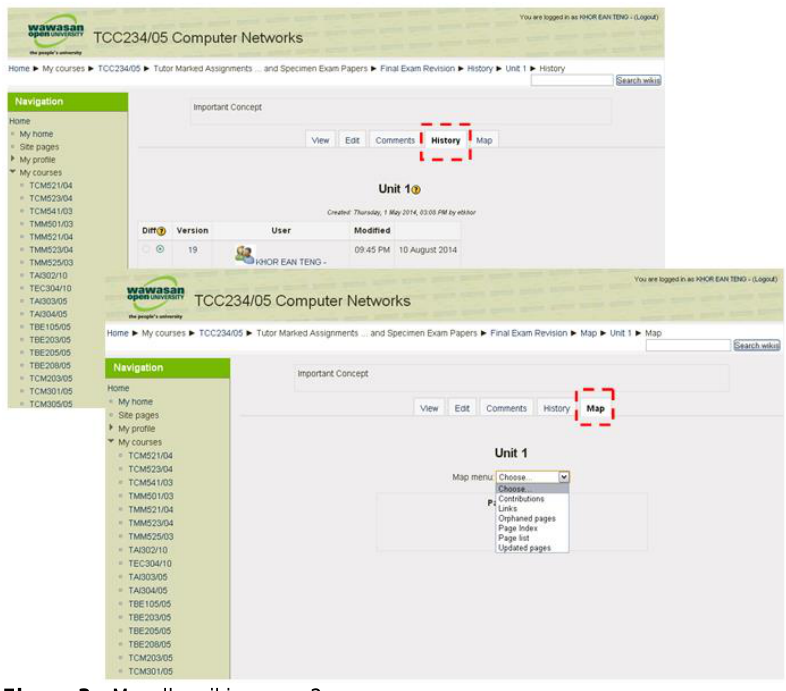
Figure 3 Moodle-wiki screen